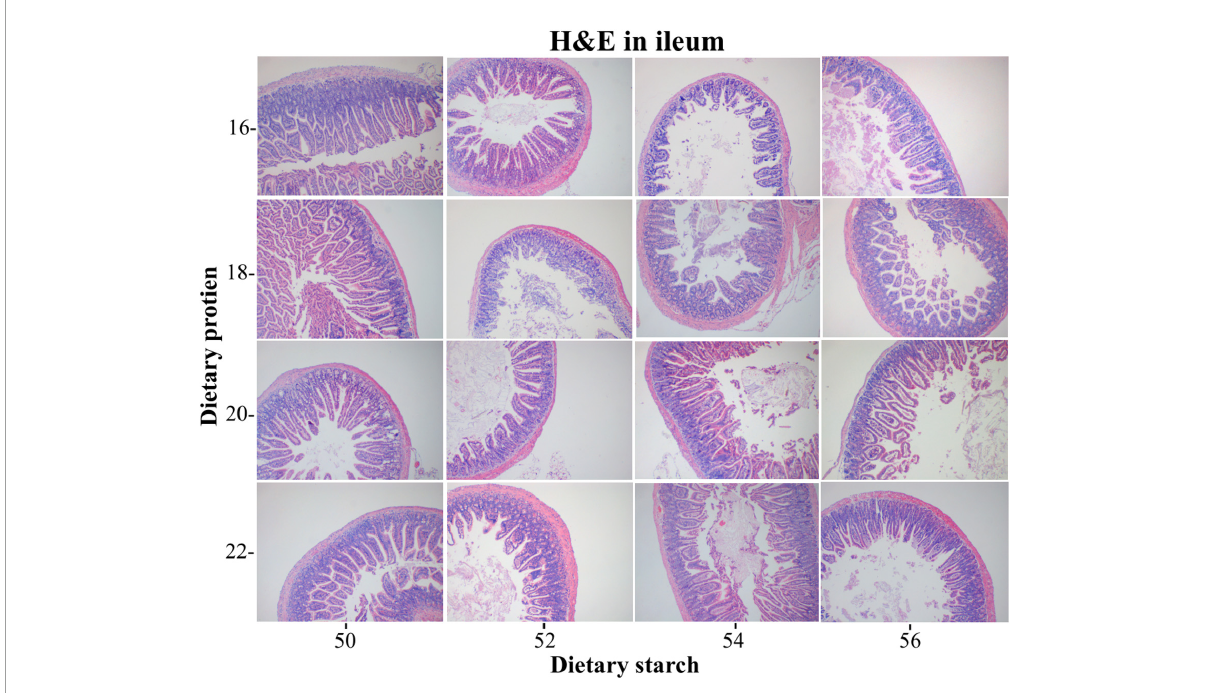
FIGURE3 Light microscopy cross-section of ileal tissue by different ratios of starch and protein in